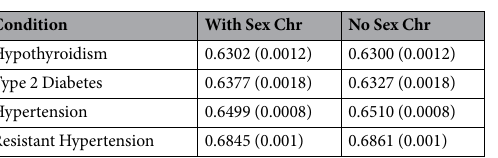
Table 3. AUCs obtained using sex and age alone, SNPs alone, and all three together.